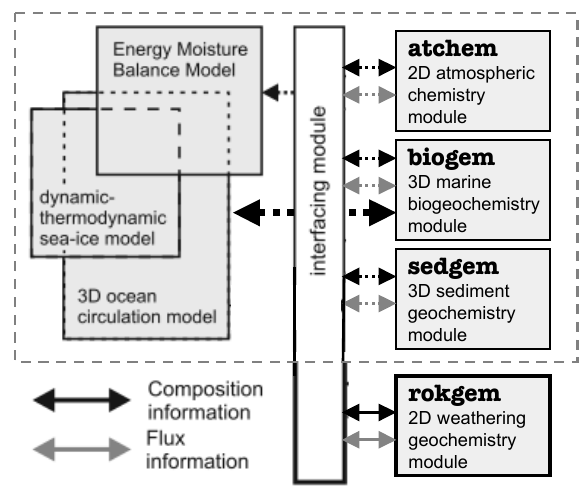
Fig. 1. Schematic of the relationship between the different model components comprising the GENIE-1 model. Outlined in bold is the weathering module RoKGeM described in this paper, while the ocean-atmosphere-sediment carbon cycle and climate model (Ridgwell and Hargreaves, 2007) is delineated by a dashed box. Figure adapted from Ridgwell and Hargreaves (2007)